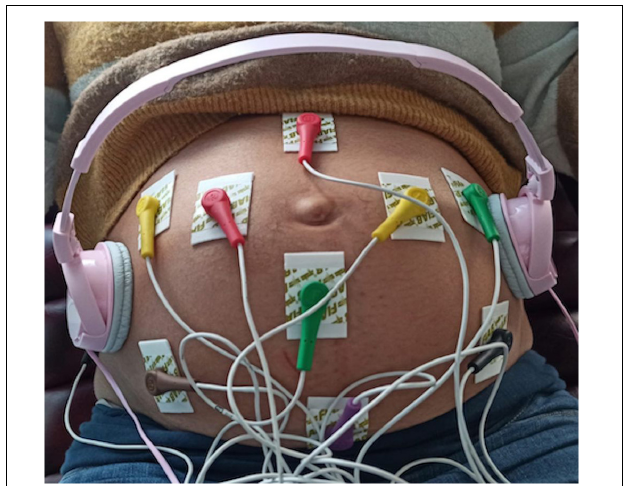
FIGURE 1 | Scheme of 10 electrodes placed on the maternal abdomen during musical